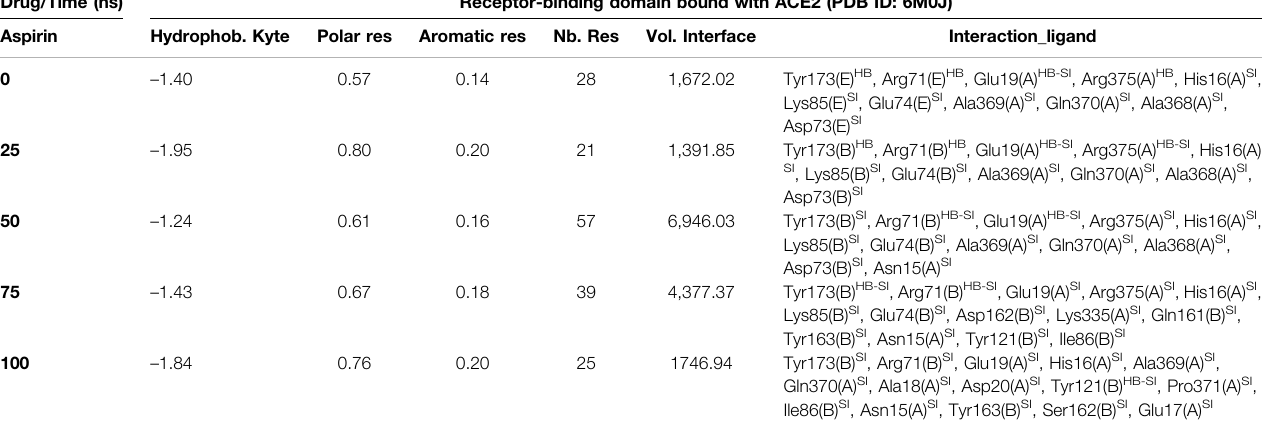
TABLE 6 | Biophysical characteristics associated with the amino acid composition of the Aspirin binding pocket at the RBD-ACE2 interface and as a function of simulation time. Drug/Time (ns) Receptor-binding domain bound with ACE2 (PDB ID: 6M0J) Aspirin Hydrophob.